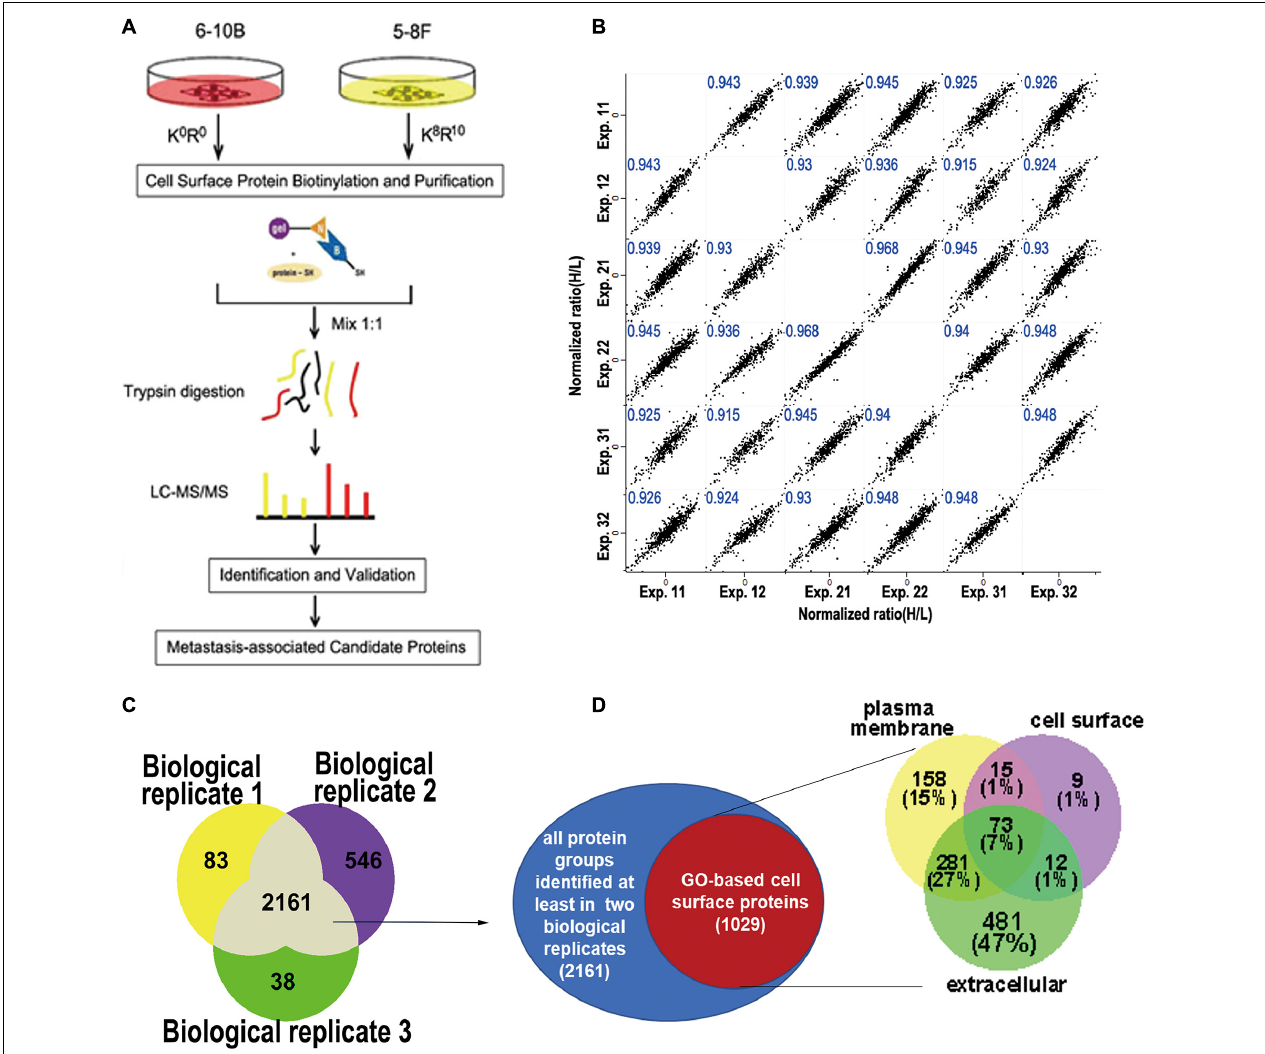
FIGURE 1 | Experimental workflow for cell surface labeling and preparation for mass spectrometry. (A) Workflow of SILAC mass spectrometry-based analysis of the cell surface proteome, where 6-10b and 5-8F cells were labeled with “light” and “heavy” amino acids, respectively. (B) Scatter plot of protein ratio (5-8F vs. 6-10B) between the biological and technical replicates of the cell surface proteome. The Pearson correlation coefficient is presented in blue at the top of each plot. (C) Venn diagram showing the number of identified proteins from three biological replicate experiments. (D) Identified proteins grouped by their annotated subcellular localization (UniProtKB). Surface-exposed proteins represented by their annotated detailed categories are shown in the Venn